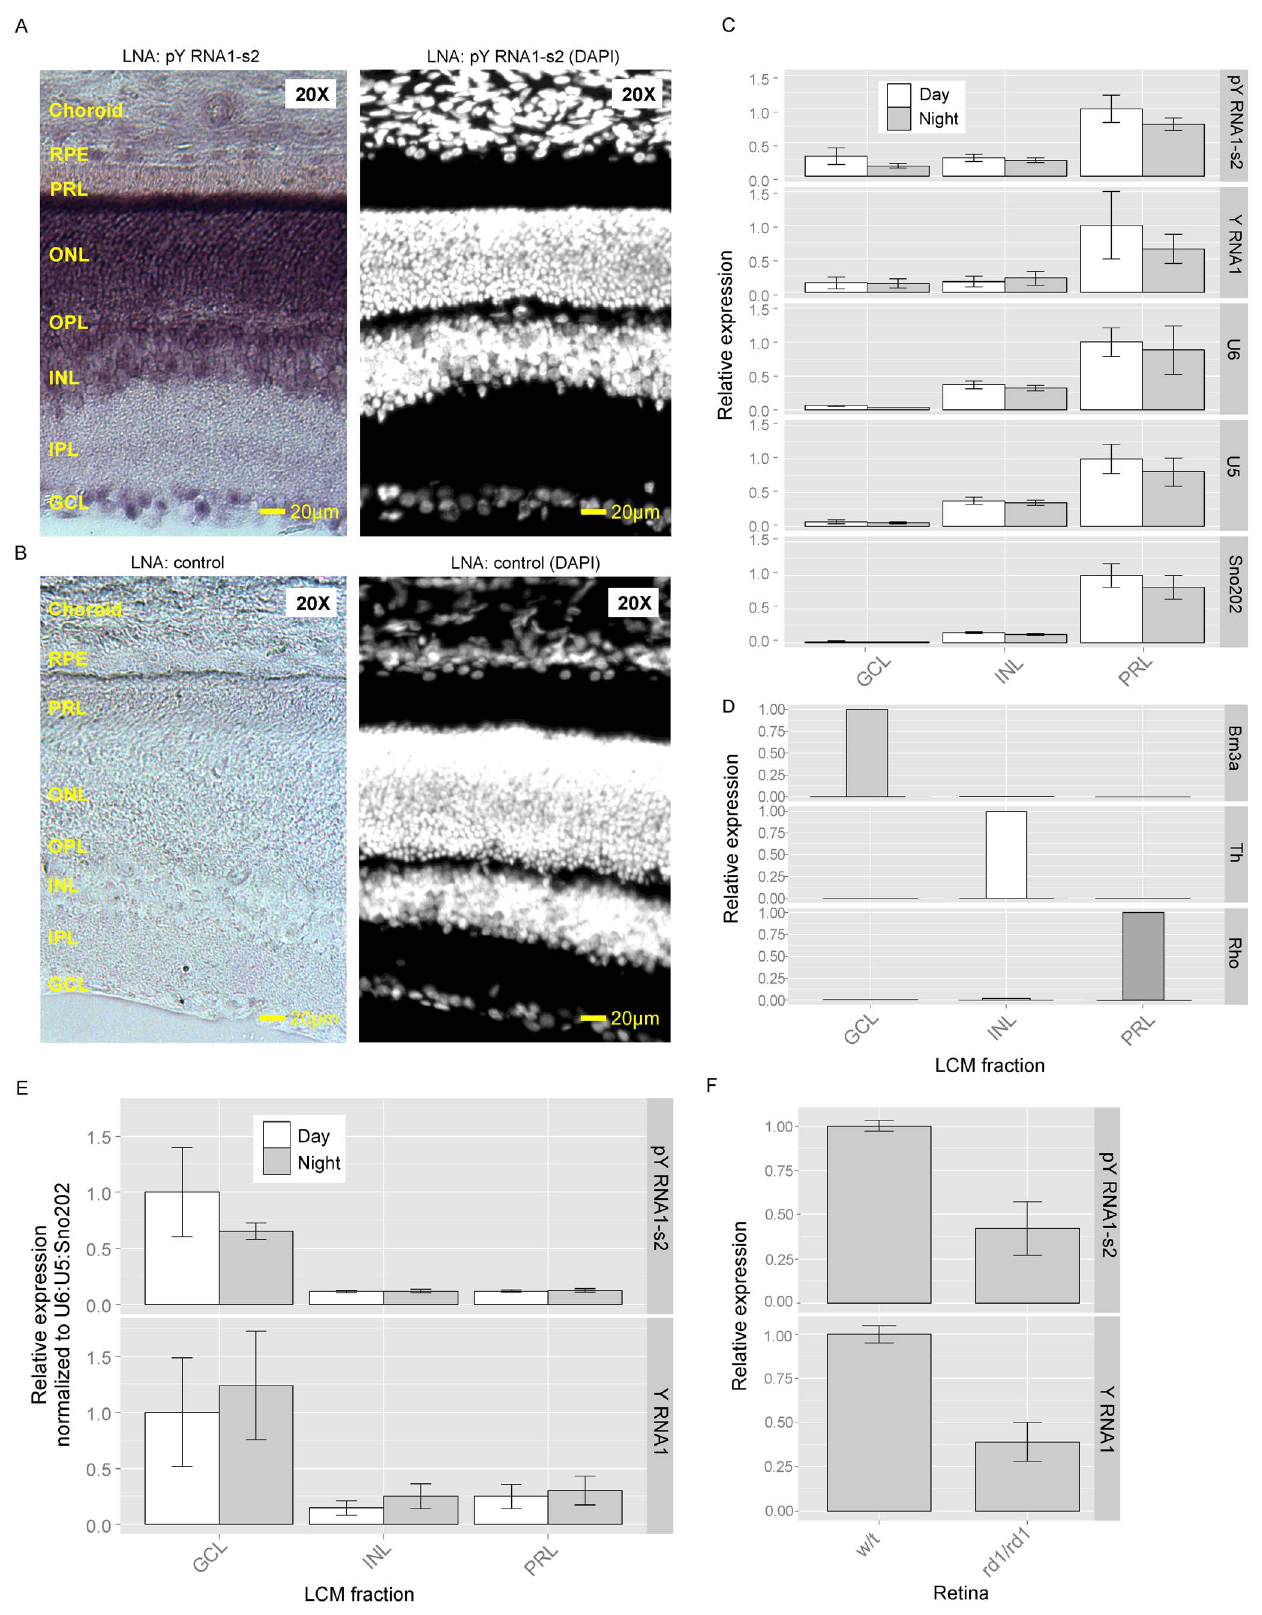
Figure 3. A. pY RNA1-s2/Y RNA1 is enriched in the ganglion cell layer (GCL) and photoreceptive layers (PRL) of retina. An antisense dioxygenin-labelled Locked Nucleic Acid (LNA):DNA probe was used to identify the location of Y RNA1 and pY RNA1-s2 in the retina of rat; full details